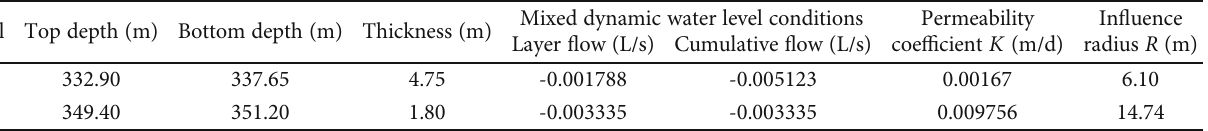
Table 2: Main shaft aquifer parameters.